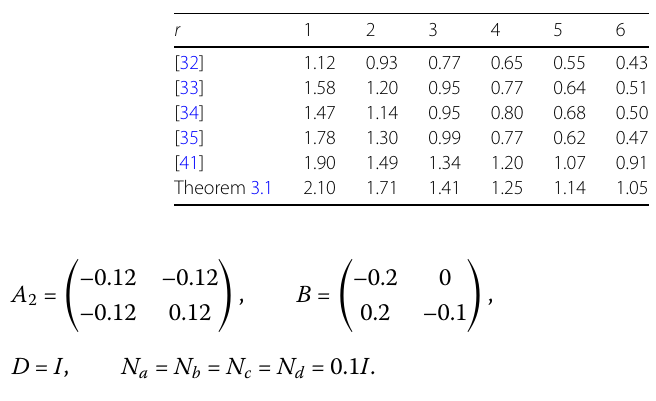
Table 2 The MAUB of h for τ = 0.1 and different values r in Example